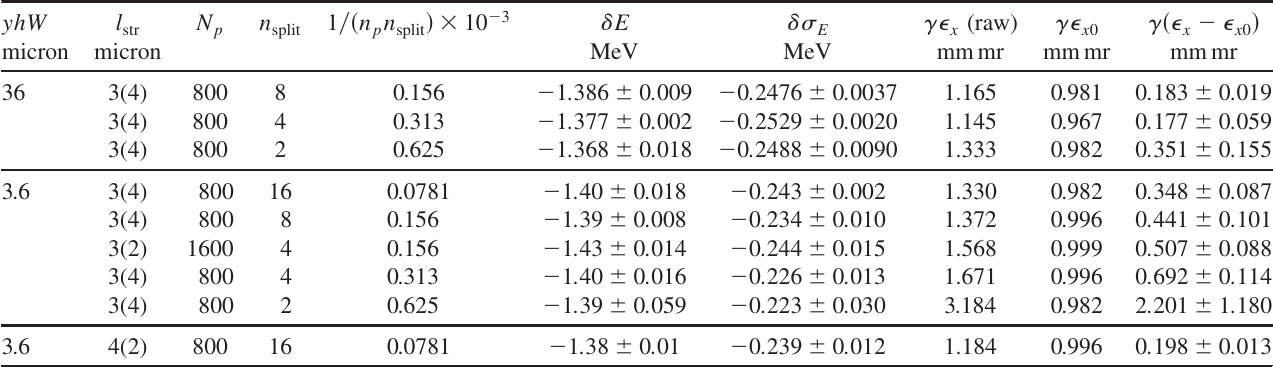
TABLE VI. Output bunch parameters for the standard chicane with nominal parameters. All beam measures except (cid:1) x are essentially independent of all variables exhibited. The parenthesized entries in the second column indicate the number of independent computer runs performed to obtain the remaining entries. Column heading yhW stands for bunch half-height.